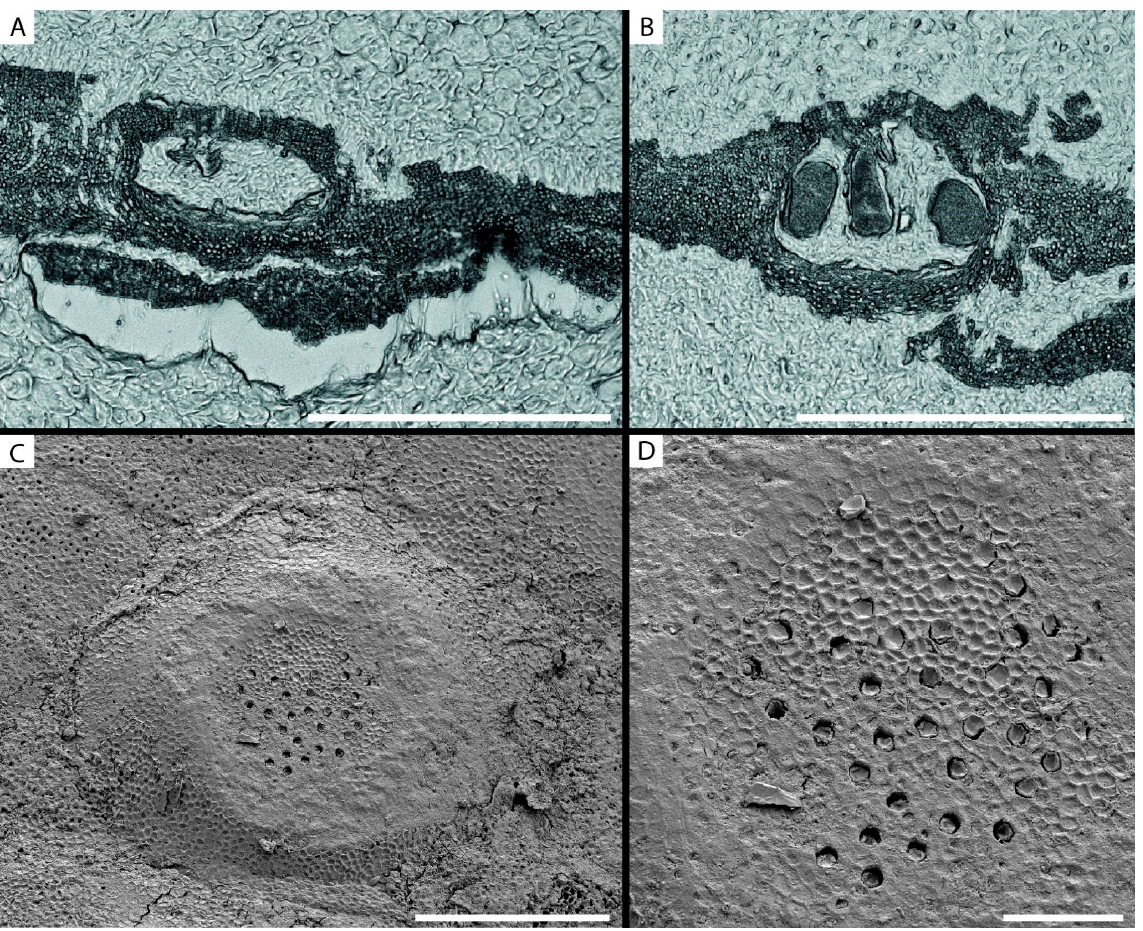
Figure 3. Vegetative features of T. antarcticum in histological sections ( A – B ) and under SEM ( C – D ), showing longitudinally oriented, tetrasporangial conceptacles ( A – B ) with surface view of the multiporate, dome shaped plates ( C – D ). Scale bars = 400 µm ( A – B ), 200 µm ( C ), 50 µm ( D ). Table 1. Maximum Likelihood Estimate of Substitution Matrix.